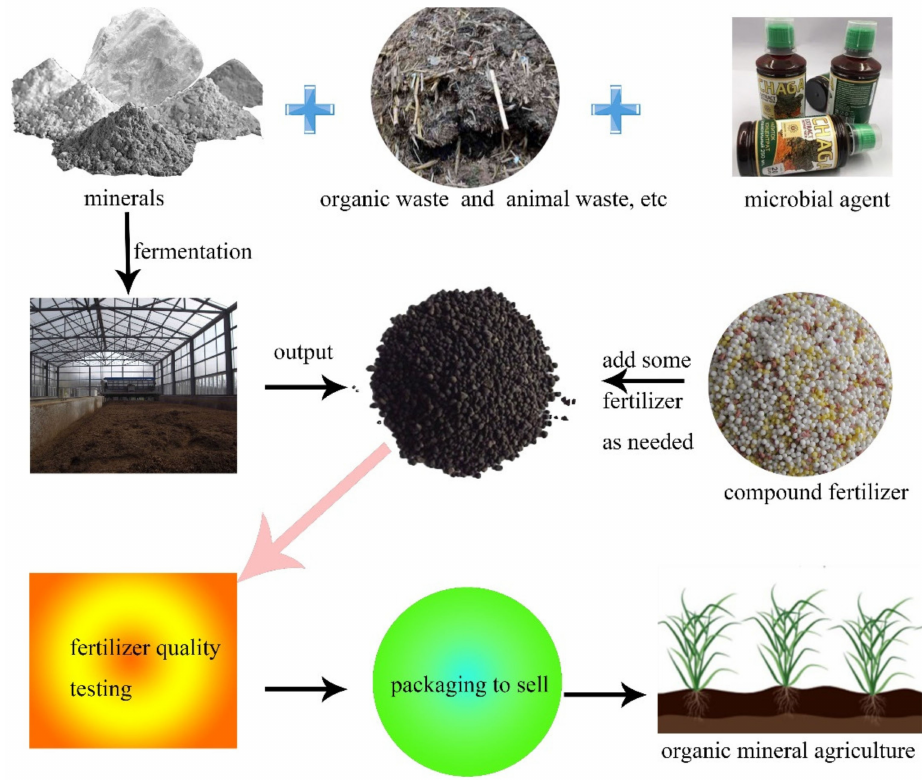
Figure 1. Simplified production process of